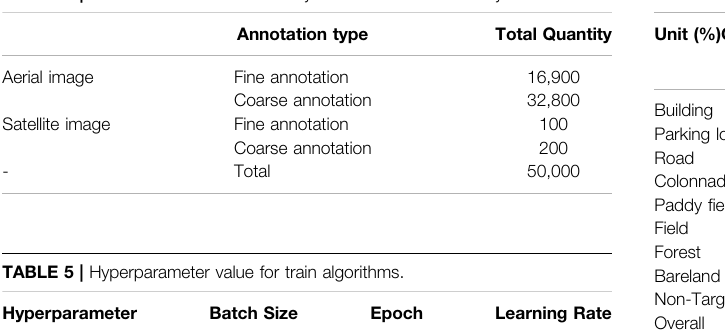
TABLE 4 | The amount of data set fi nally constructed in this study.